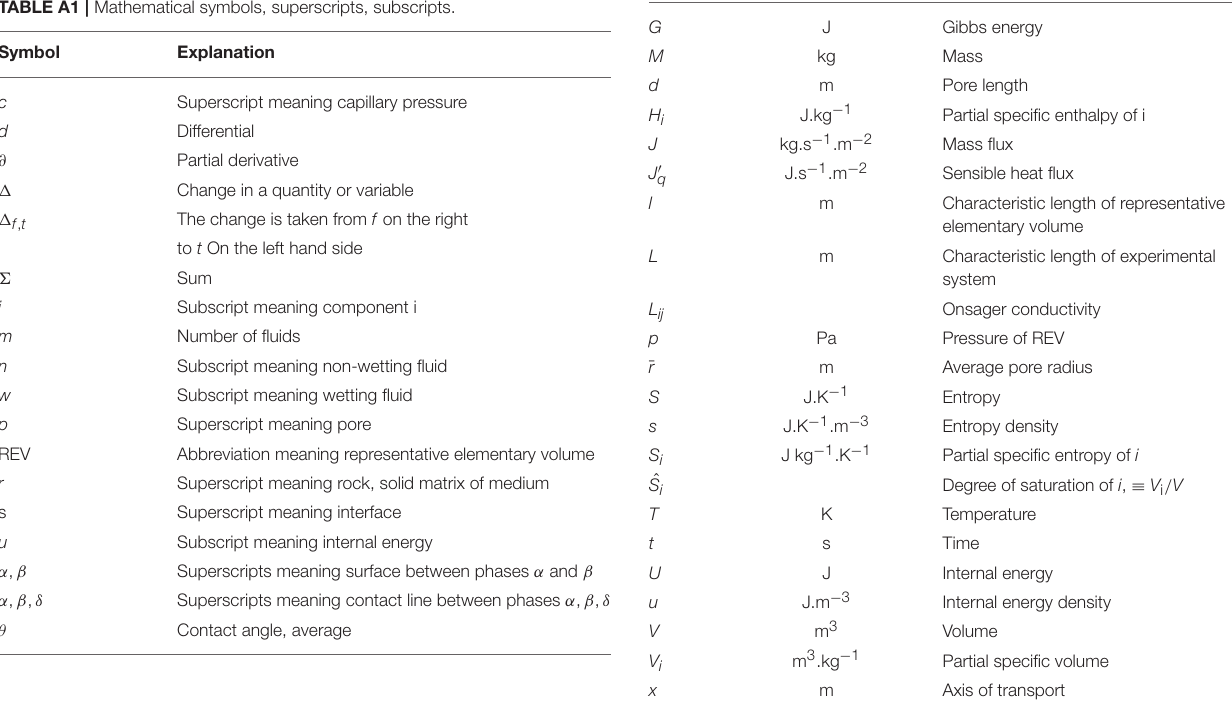
TABLE A1 | Mathematical symbols, superscripts,